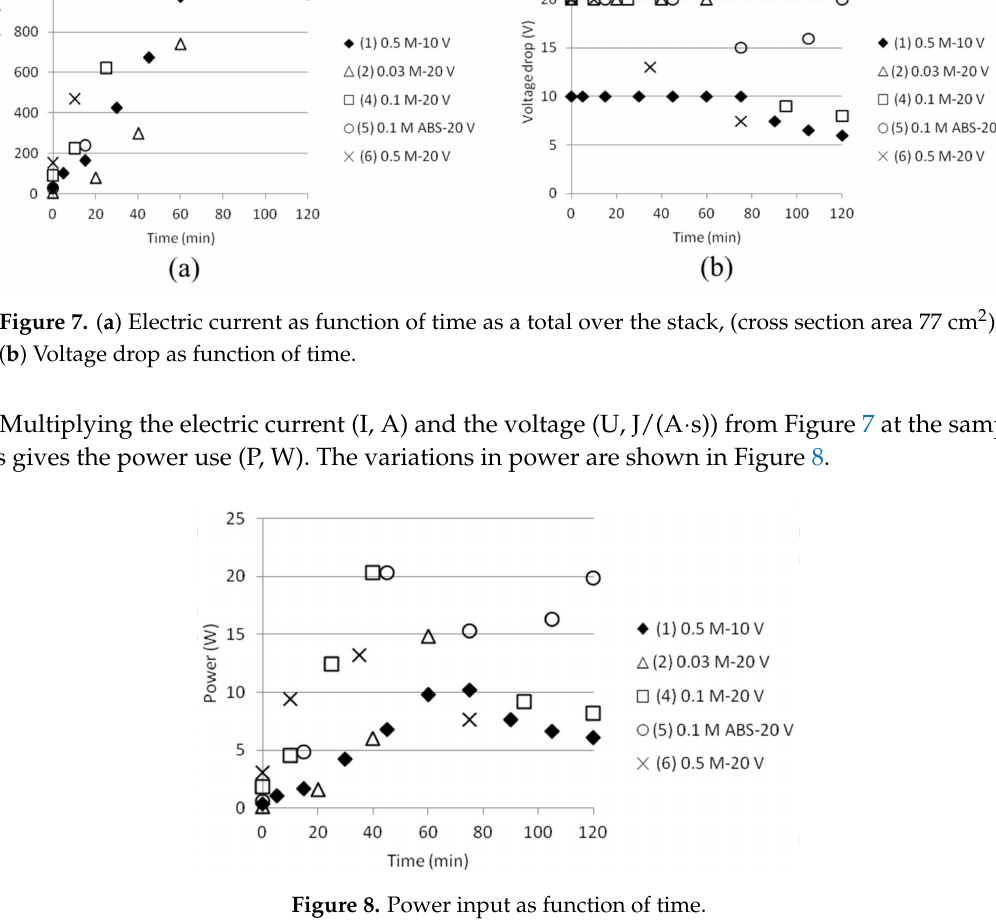
Figure 8. Power input as function of